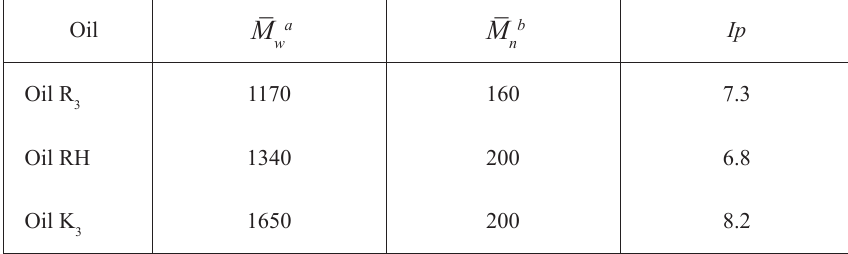
Table 5. Analysis of the oils by SEC Oil M̅ wa M̅ nb Ip Oil R 1170 160 7.3 3 Oil RH 1340 200 6.8